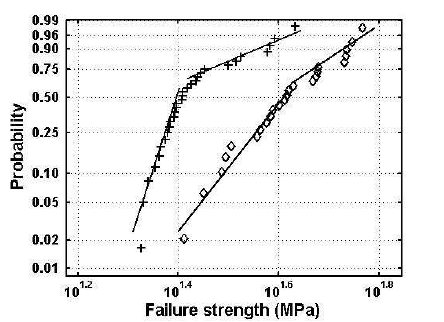
Figure 5: Weibull plot of the results for annealed glass